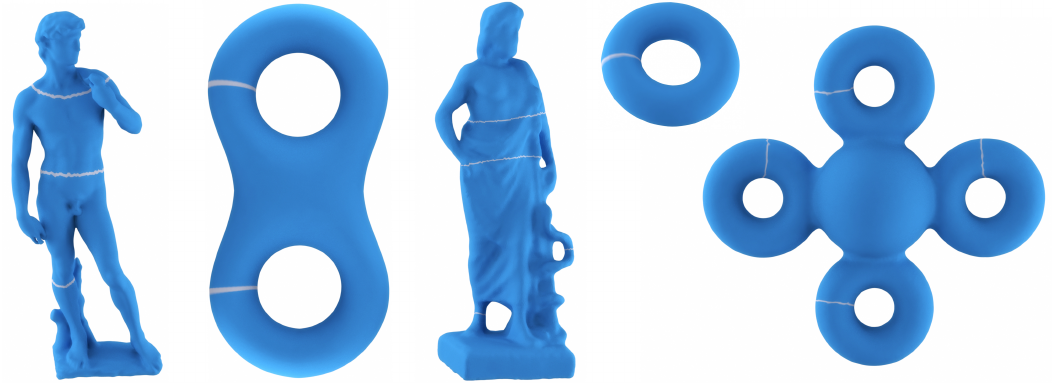
Figure 21. Examples of cut system curves on triangulated